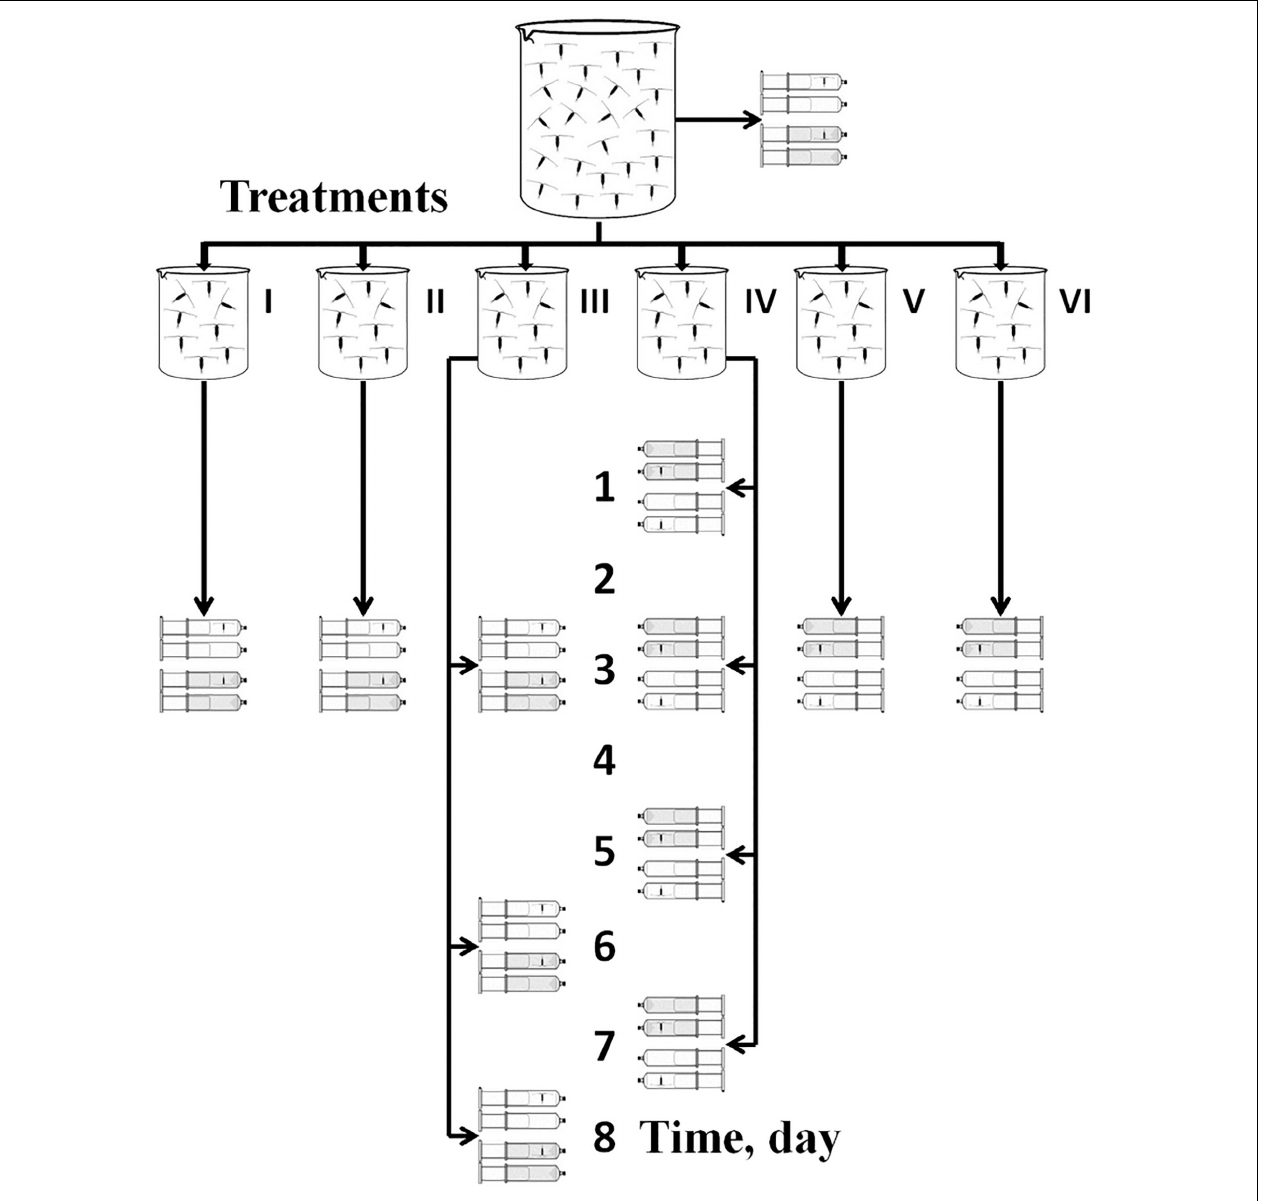
FIGURE 2 | Schematic diagram of the experimental design adopted in the present study for respiration rate experiments. Four syringes for each day of each treatment (I = RESP1, II = RESP2, ... and so on) indicate four types of oxygen concentration measurements: (a) in syringes with active females (gray syringes with copepods), (b) in syringes with anesthetized females (white syringes with copepods) and monitoring oxygen concentration in control syringes for each of the active and anesthetized individuals (syringes without copepods). The number of repetitions for each treatment is given in the text and in Table 3